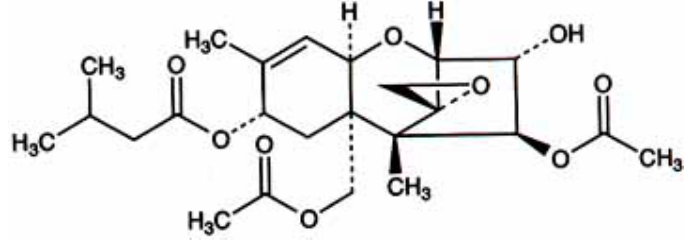
FIGURE 1 . Representative molecular structure of trichothecene: T-2